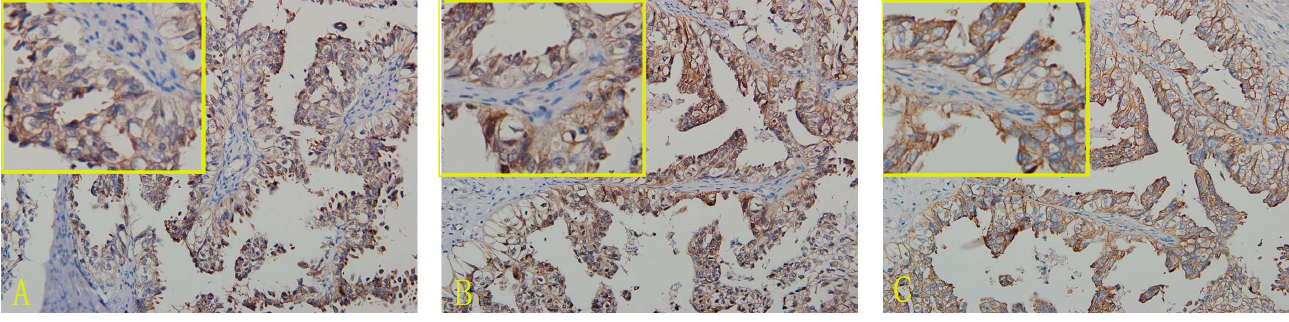
Figure 1. Immunohistochemical micrographs of CD44, CD47 and c-met in ovarian clear